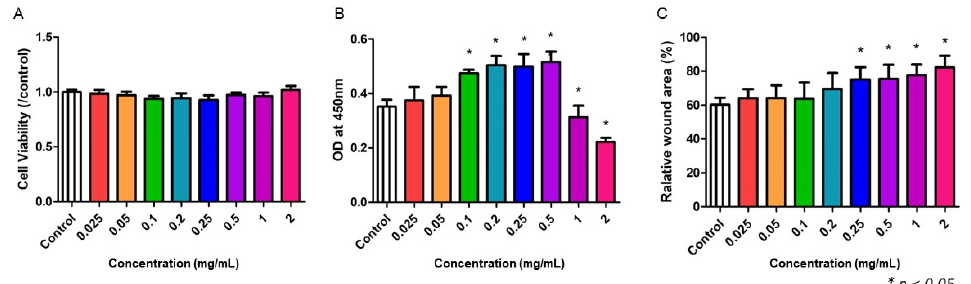
Figure 8. The effect of NF3 on FR. Different doses of NF3 (0.25–2 mg/mL) were added to FR cultivation. ( A ) MTT. No cytotoxic effect was observed in any of the doses. ( B ) BrdU. The proliferation ability was enhanced when a medium dose of NF3 was supplied (0.1–0.5 mg/mL) ( p < 0.05). As the dose increased (1–2 mg/mL), the proliferation was suppressed significantly ( p < 0.05). ( C ) Scratch test. A high dose of NF3 (0.25–2 mg/mL) promoted the cell mobility in FR ( p < 0.05). 2.9. NF3 Reduced the Levels of Nitric Oxide (NO), IL-6, MCP-1, and TNF- α Released from RAW 264.7